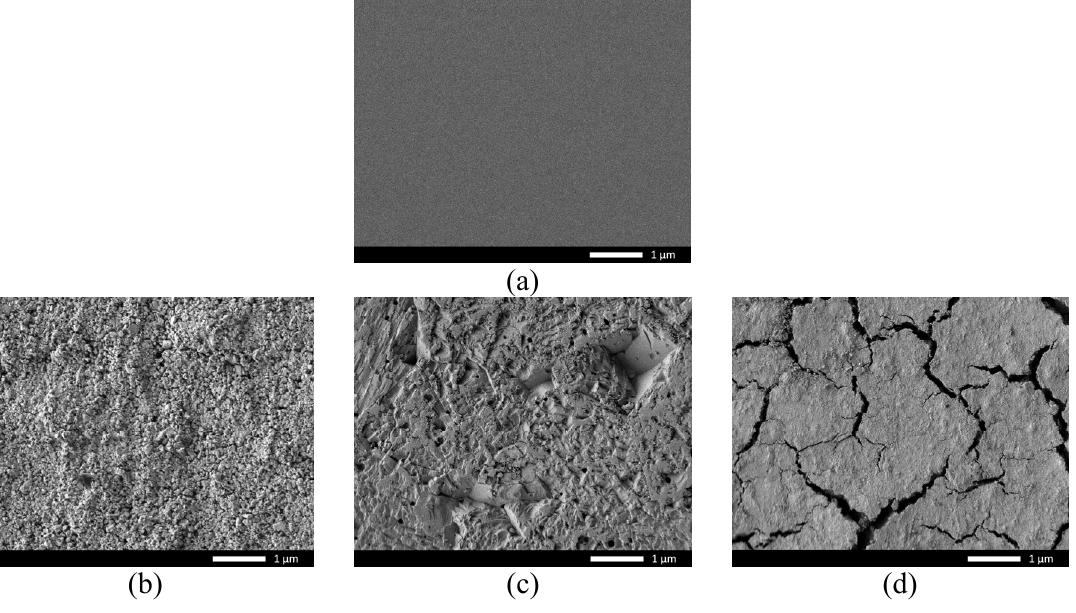
Figure 8. SEM images of ceramic: ( a ) initial sample; ( b ) initial sample after aging; ( c ) proton irradiation after aging; ( d ) helium ion irradiation after aging.